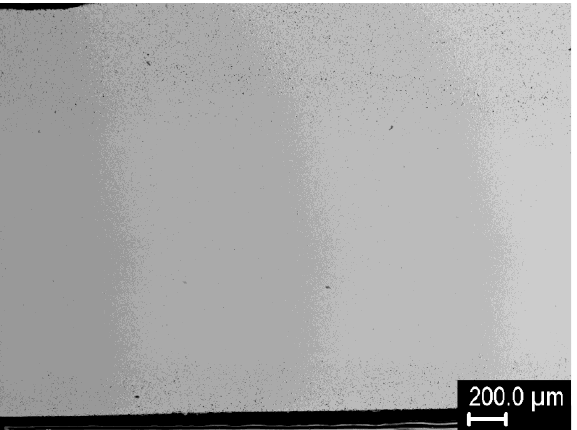
Figure 2. Cross-section of tungsten compact sintered at 1900 ◦ C from the − 20 µ m powder. Table 1. Effect of sintering pressure on porosity (at 1600 ◦ C).